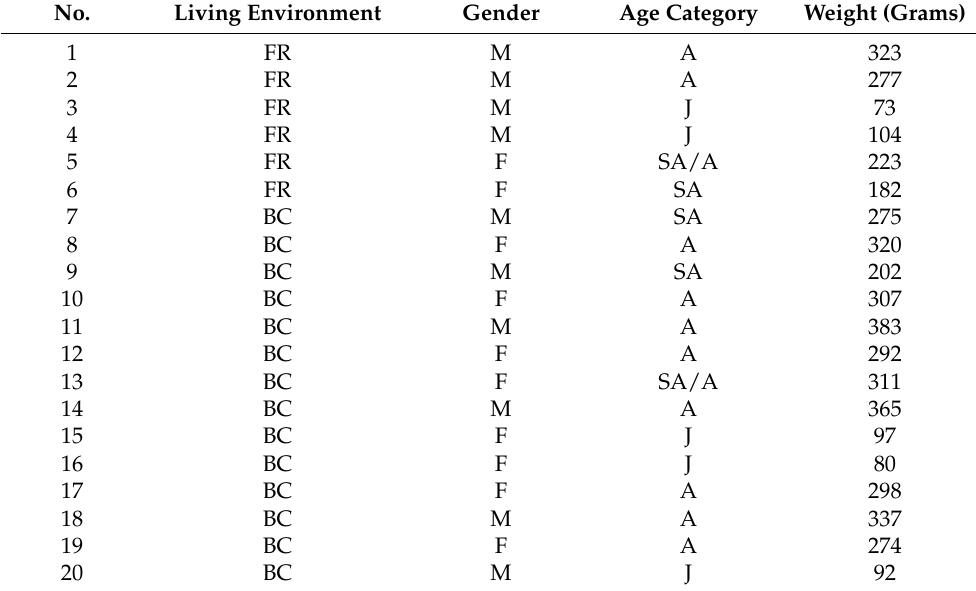
Table 1. Characteristics of the squirrels sampled for the study. No. Living Environment Gender Age Category Weight